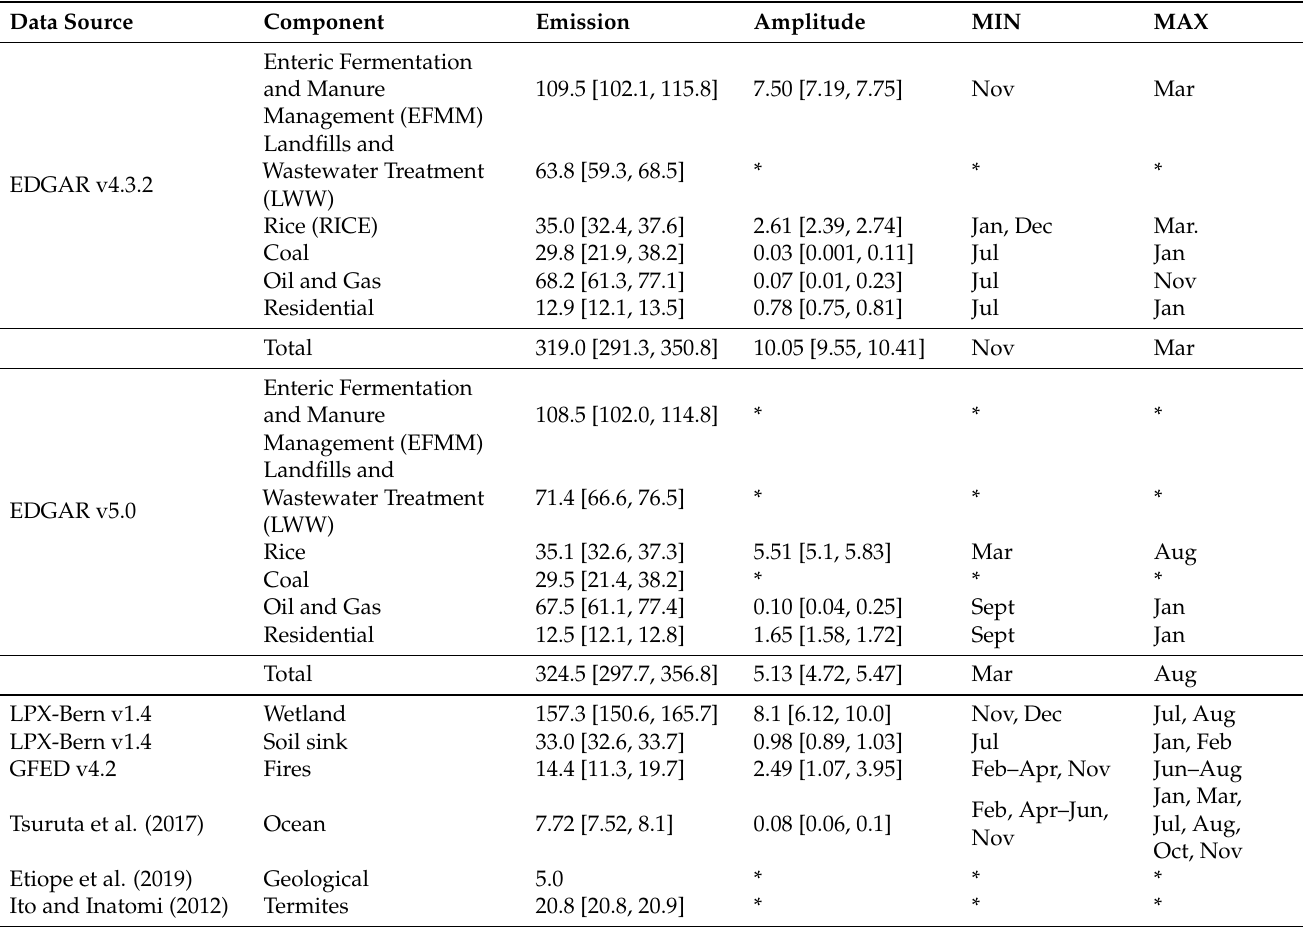
Table 2. Average global emission (Tg CH 4 year − 1 ) and emission amplitude (Tg CH 4 month − 1 ) over years 2000–2012 with range, and the months when seasonal minimum and maximum occurs. For EDGAR components, those for 2010 and 2015 for v4.3.2 and v5.0 are shown, respectively. For natural sources, the variation shows those between different years. Those marked with “*” do not have monthly variations. Note that geological emissions are kept constant during the